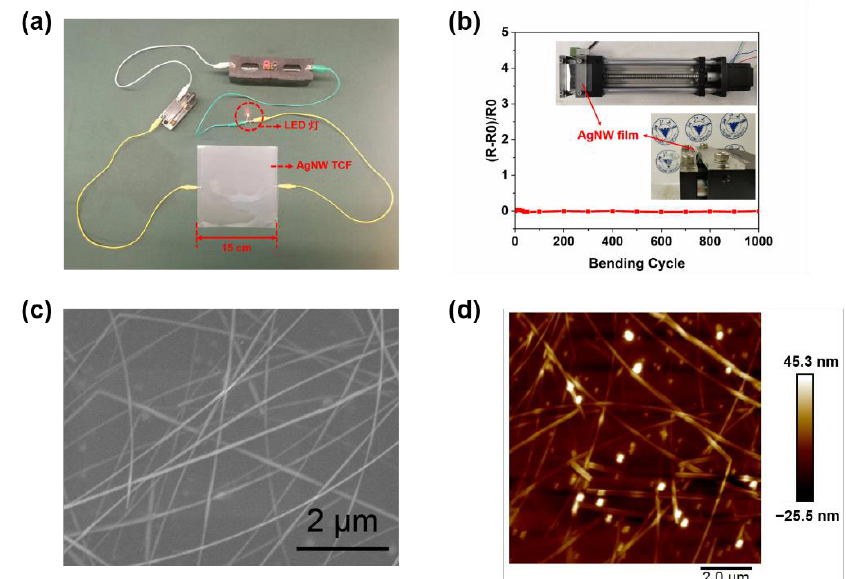
Figure 6. ( a ) The photograph of AgNW TCF (15 cm × 15 cm) connected in series with a power supply, LED, switch, and wires. ( b ) Variations in resistance of the optimized AgNW TCF during repeated bending test. ( c ) SEM morphology of the optimized AgNW TCF ( d ) AFM image of the optimized AgNW TCF. Table 1. Optoelectronic properties of the optimized AgNW TCF compared with other similar